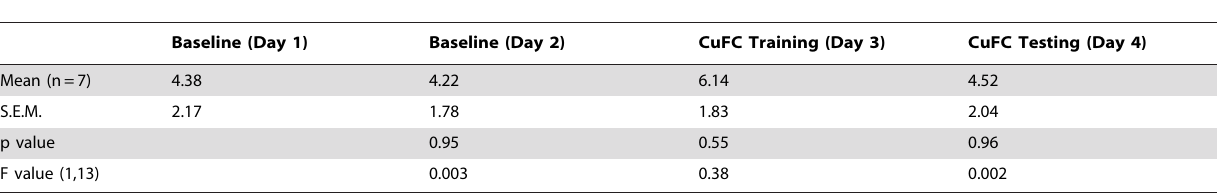
Table 1. Changes in percent freezing response in the tone control